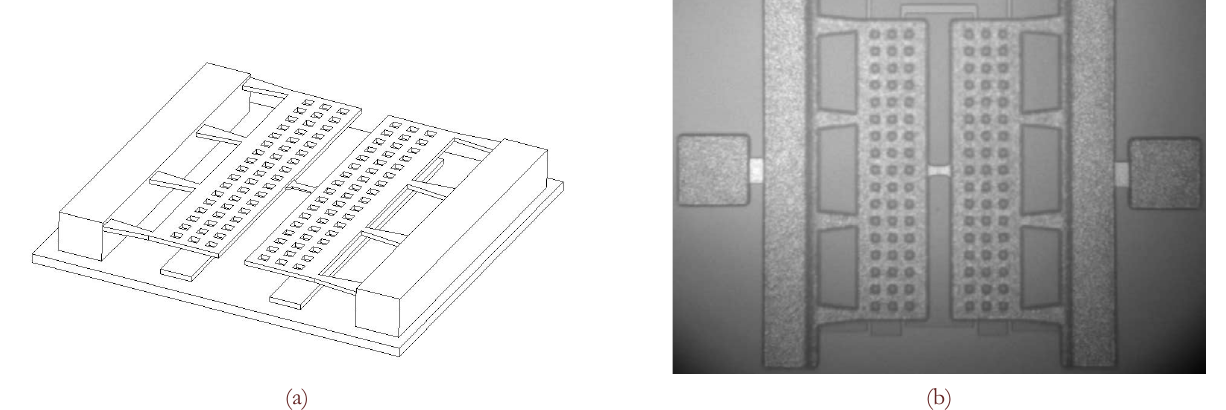
Figure 2: Geometrical shape of the testing device for tensile fatigue loading where the gap thickness is enlarged (a) and SEM image of the actual device (b).